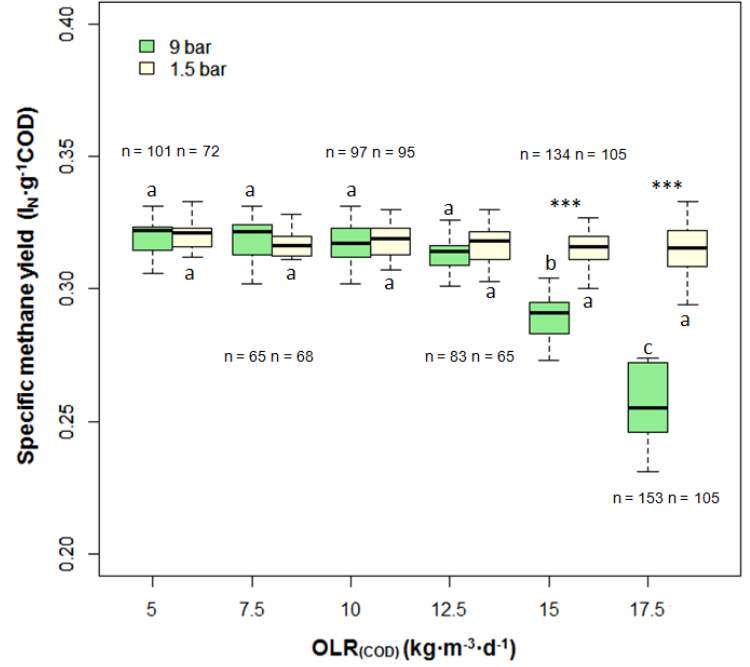
Figure 3. Specific methane yield at different OLR and pressure levels. The box plot is characterized with the minimum, low quartile, median, upper quartile and maximum value. Significant differences among the OLR levels are marked with different letters ( p < 0.05, LSD test) and the significant differences among the pressure levels are